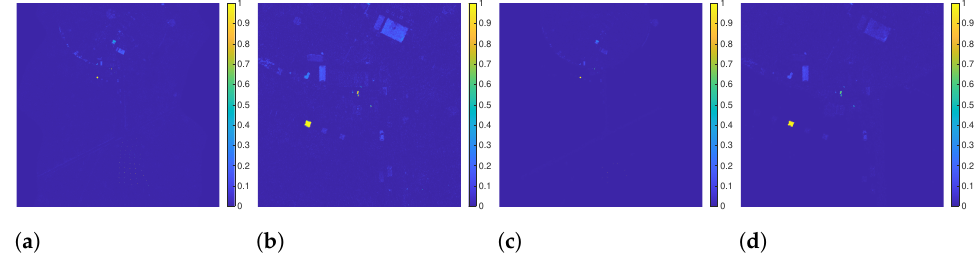
Figure 16. Detection statistics of the ACE algorithm on the full dimensionality data where yellow indicates a response of 1 and blue represents a response of 0. ( a ) Without spatial DR. ( b ) Enlarged version of ( a ). ( c ) With NDVI re . ( d ) Enlarged version of ( c ). The ROC curves in Figure 17a,b are of the ACE detection statistics on the full scene and NDVI re -based spatial DR scene, respectively. The two sets of ROC curves are almost identical and do not provide definitive results, but indicate a small improvement when using the spatial DR. Comparing the PR curves in Figure 17c,d shows that when each spectral DR scheme is used in conjunction with spatial DR the AUC is increased by 10–15%.